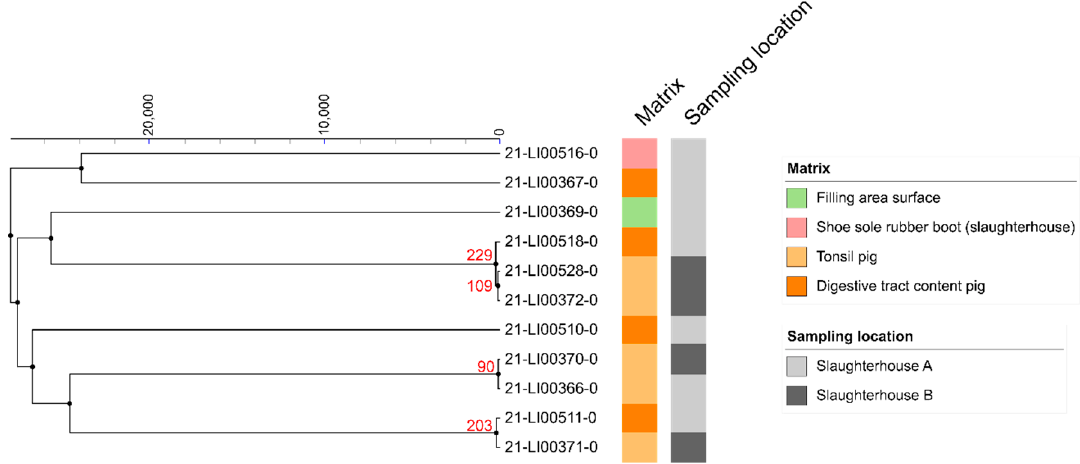
Figure 2. Clustering of 11 L. innocua isolates found in pigs and the slaughterhouse environment in a linkage tree with differences of less than 1,000 SNPs indicated.